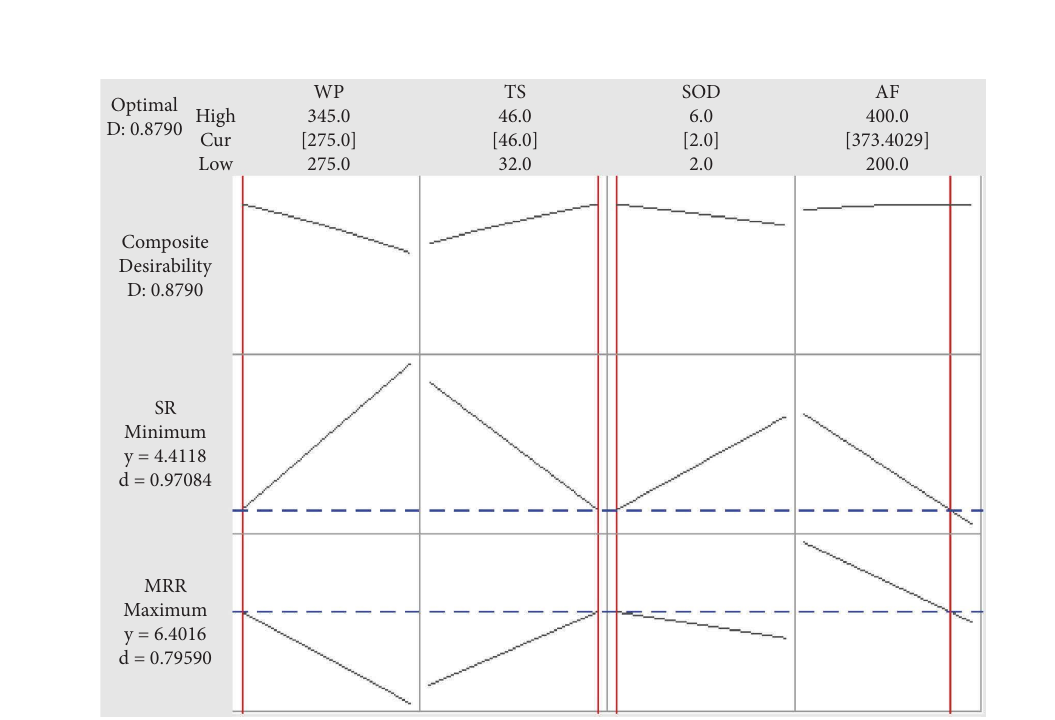
Figure 3: Response optimization plot of